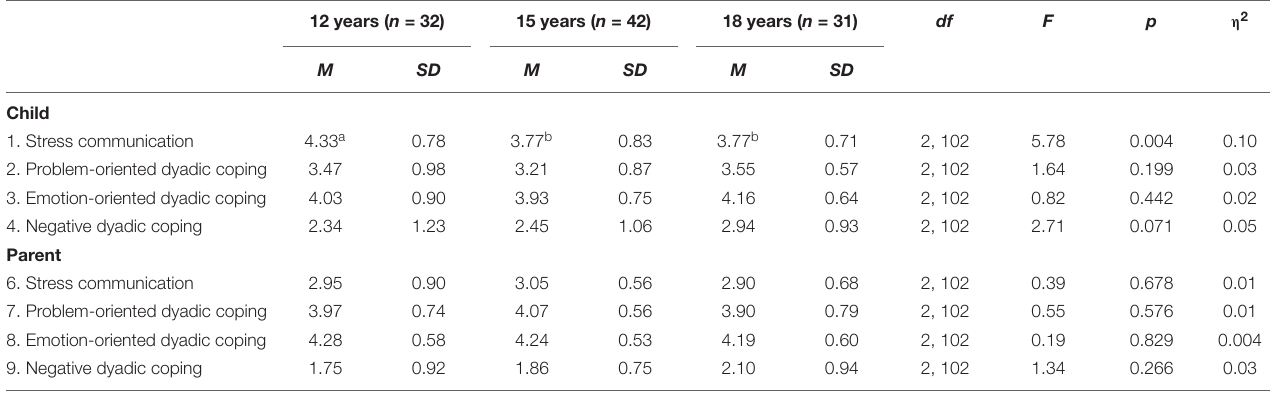
TABLE 2 | Means and standard deviations of different forms of dyadic coping per age group. 12 years ( n = 32) 15 years ( n = 42) 18 years ( n = 31) df F p η 2